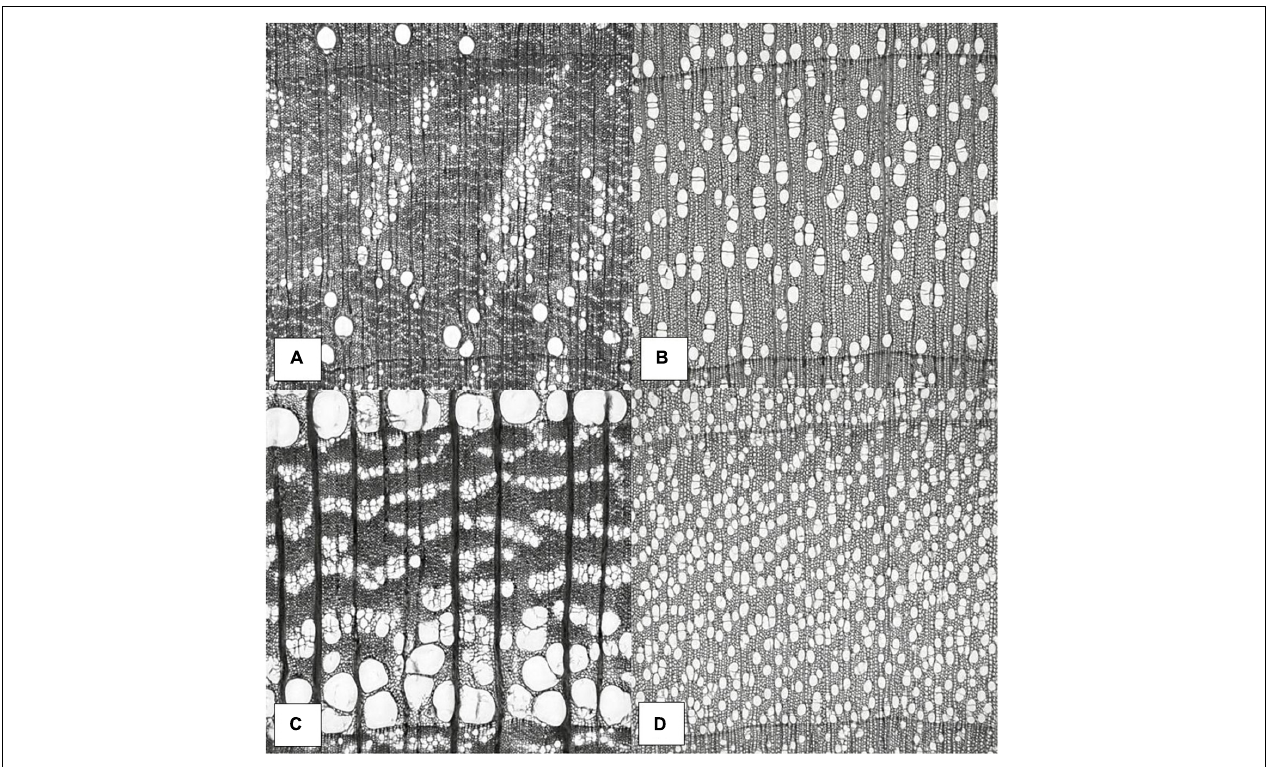
FIGURE 4 | Wood anatomy images generated by StyleGAN. Synthesis of anatomical elements. Potential semi-ring-porous wood (A) , diffuse-porous wood (B) , ring-porous wood (C) , and diffuse-porous wood (D)